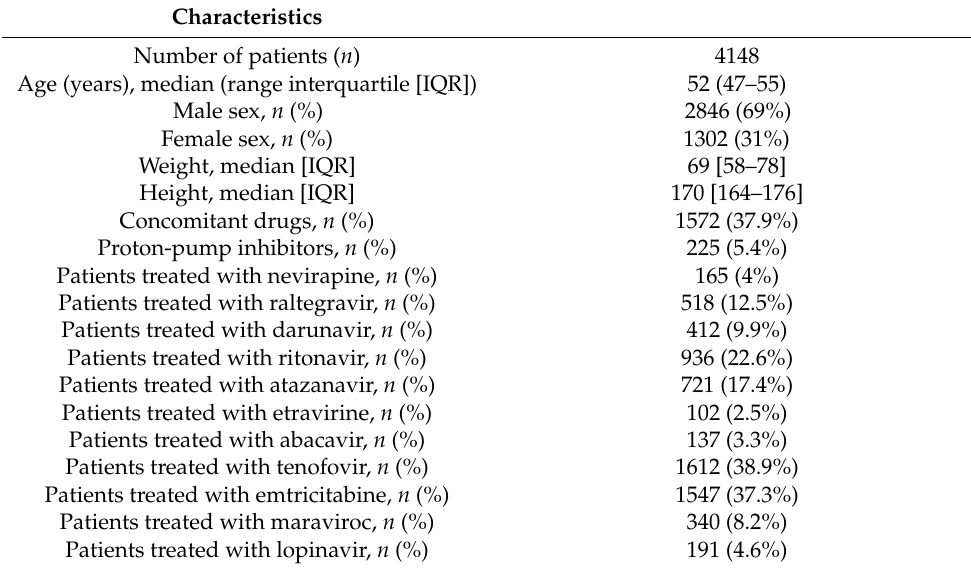
Table 1. Characteristics of the described population.